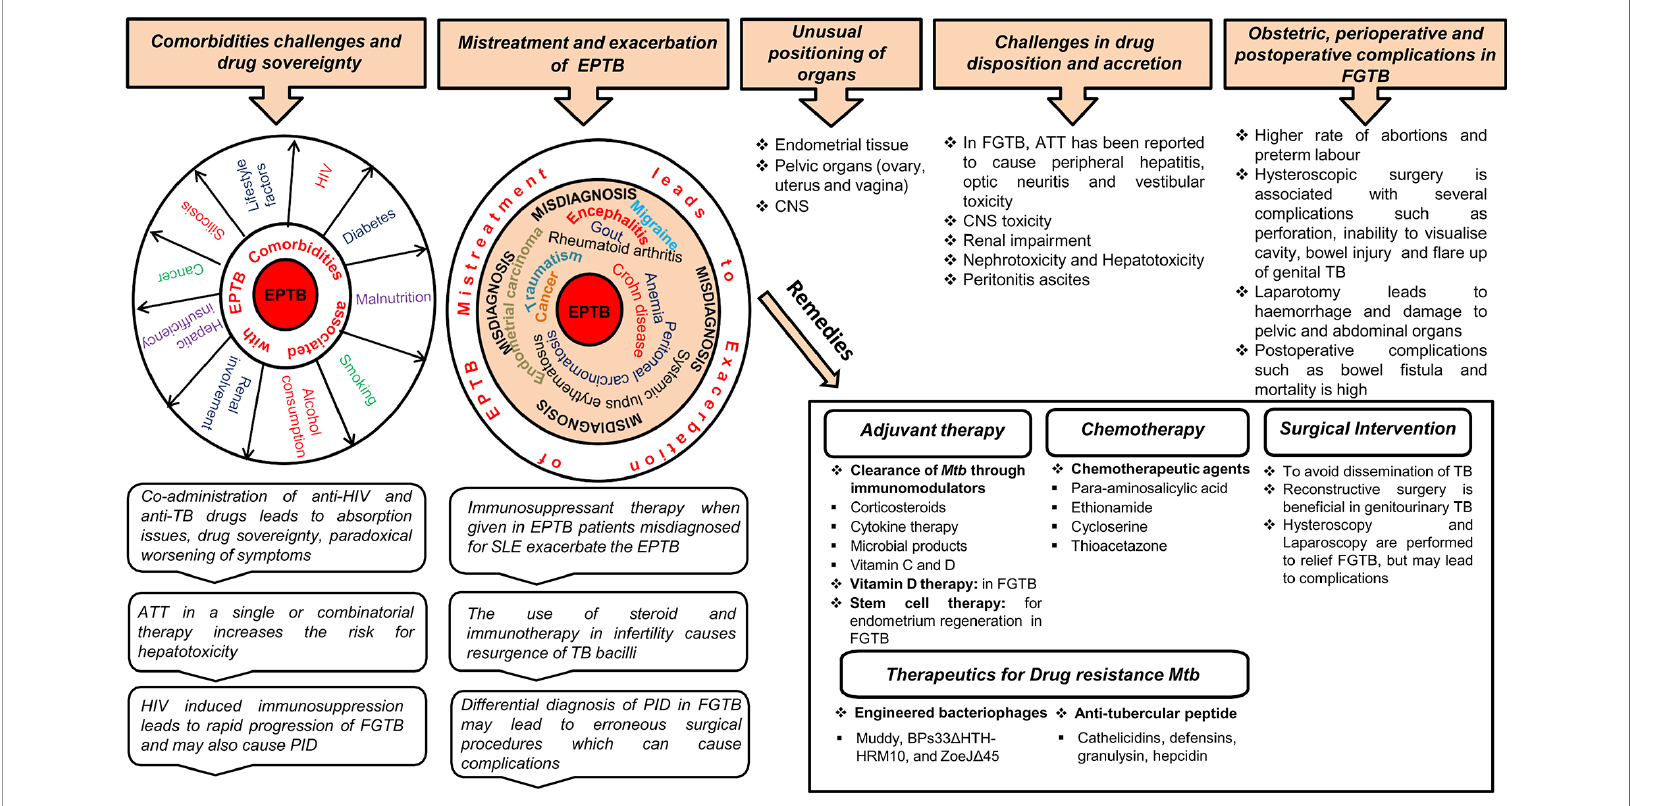
FIGURE 2 | Treatment challenges and remedies for EPTB, in particular, FGTB. Various comorbidity challenges associated with EPTB are depicted. The risk of EPTB, particularly FGTB, occurrence increases in a comorbid condition depending on the severity of immunosuppression associated with these diseases. Coadministration of drugs results in drug sovereignty, toxicity, absorption issues, and paradoxical reactions in the body, which can further exacerbate the condition. EPTB misdiagnosis and subsequent mistreatment suppress the immune system to such an extent that it increases the bacterial prepotency of spreading to other organs (example genital organs) and exacerbation. Differential diagnosis in FGTB leads to erroneous surgical procedures, which can cause complications. ATT treatment in EPTB, in particular FGTB, faces drug disposition and accretion challenges. The unusual positioning of infected organs in EPTB illustrate treatment challenges, especially in meningitis TB, ovarian TB, urogenital TB, and endometrial TB. Due to the inaccessibility of organs in FGTB, surgical interventions are required to avoid dissemination of M. tuberculosis ; however, several perioperative complications have been observed during surgery. Erroneous surgical procedures and mistreatment lead to obstetric and postoperative complications. Stem cell therapy, chemotherapy, vitamin D therapy, and surgical interventions can be bene fi cial in FGTB, whereas adjuvant therapy is known to be effective in EPTB, and engineered bacteriophages and antitubercular peptides are used for drug-resistant